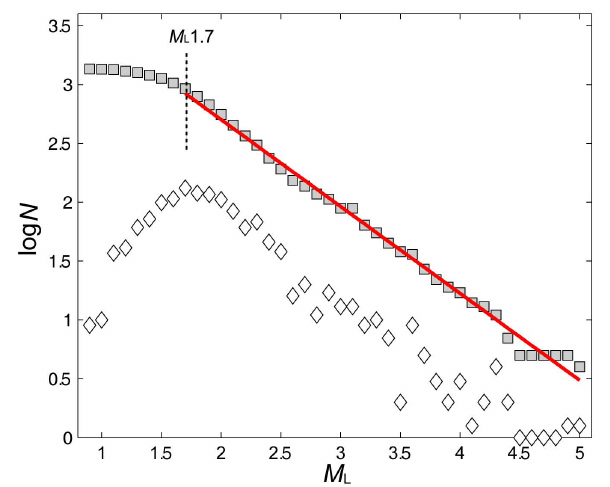
Fig. 4. Aftershocks of the 1975 Haicheng earthquake ( M L ≥ 3.0, to- taling 222 events, shown by white dots) and the 1999 Xiuyan earth- quake ( M L ≥ 2.0, totaling 82 events, shown by blue dots) as back- ground of the “multiplets”. Two groups of “multiplets” in the south- ern Liaoning region (shown by the solid box in Fig. 2) are shown by yellow dots. Stations in the surrounding of these “multiplets”, YKo and XYu, are shown by white triangles. White thick line, in- dicated by F1, shows the Haicheng River-Dayang River fault. The two crosses in black represent the epicenters of the 1975 Haicheng earthquake and the 1999 Xiuyan earthquake,